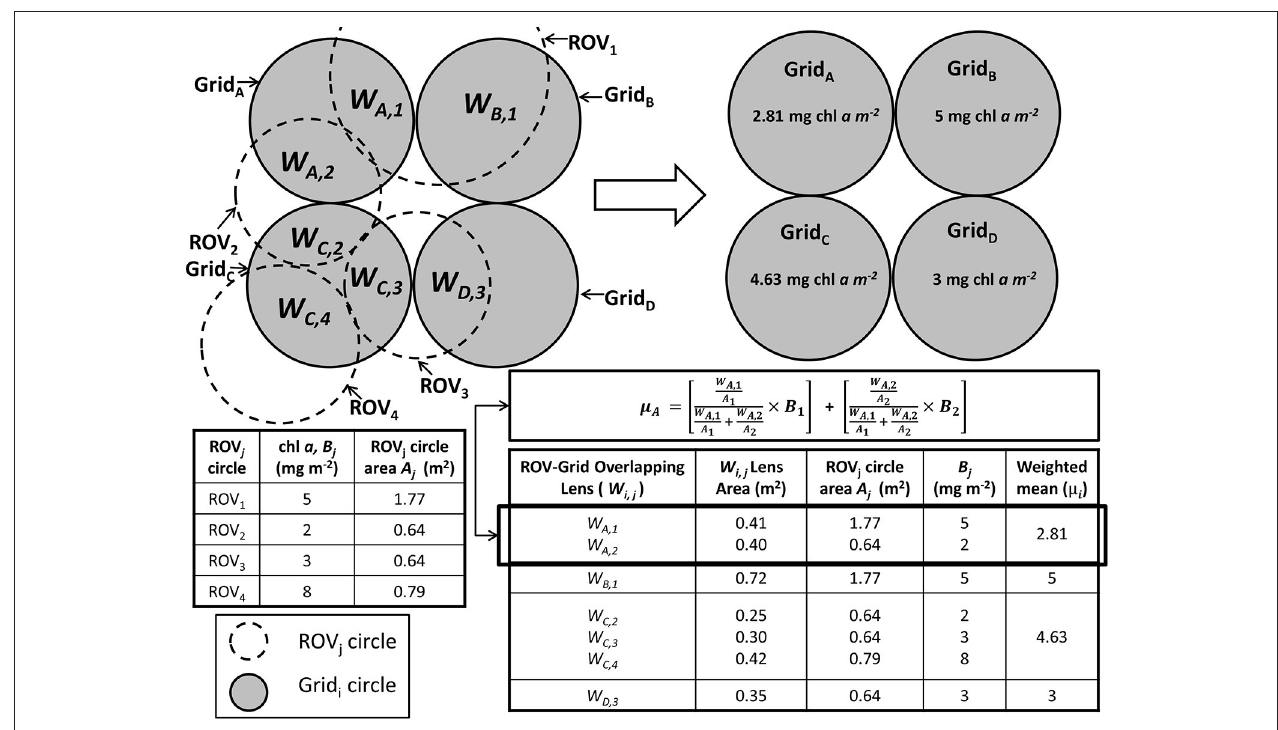
FIGURE 2 | Detailed diagram and example calculation of the re-sampling process. A grid of circles was created for the ROV measurements (e.g., ROV 1-4 circles) with each circle’s center location determined by the measurement location (x, y) and the diameter determined by the footprint of the measurement. An additional grid of circles (e.g., Grid A-D circles) was created where each adjacent circle was spaced 1m apart and each had a diameter of 1m. For each grid circle (e.g., Grid B and D ) with only one overlapping ROV circle (e.g., ROV 1 and 3 , respectively), which had an overlapping area ≥ 0.2 m 2 (e.g., W B , 1 and W D , 3 , respectively), the corresponding ROV-based transmittance and chl a were assigned to that grid circle. For each grid circle (e.g., Grid A and C ) that had more than one overlapping ROV circle (e.g., ROV 2 − 4 and ROV 1 − 2 , respectively), of which at least one ROV circle had an overlapping area ≥ 0.2 m 2 (e.g., W A , 1-2 and W C , 2-4 , respectively), weighted means (e.g., µ A for Grid A chl a ) of the corresponding ROV-based transmittance, draft and chl a were assigned to the grid circle. Weighting factors were calculated as the overlapping area of each ROV circle with the corresponding grid circle divided by the sum of all overlapping areas for that grid circle.